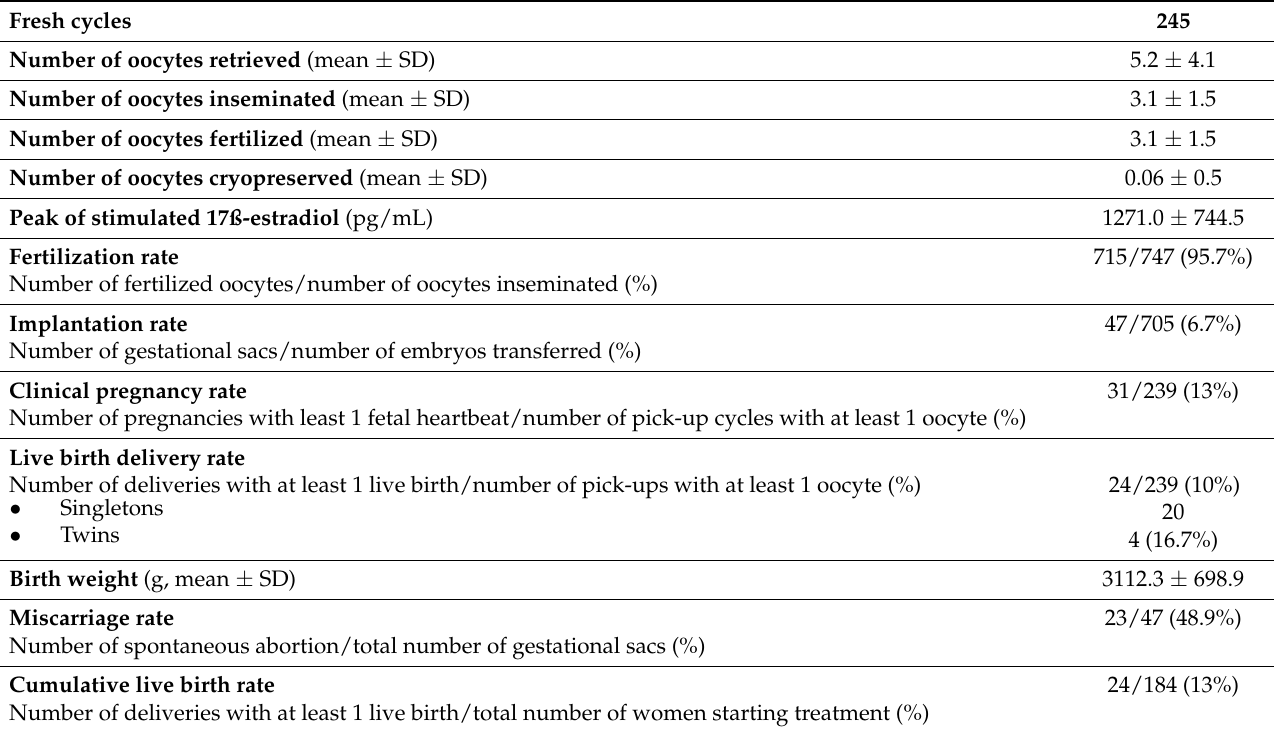
Table 2. Intracytoplasmic sperm injection